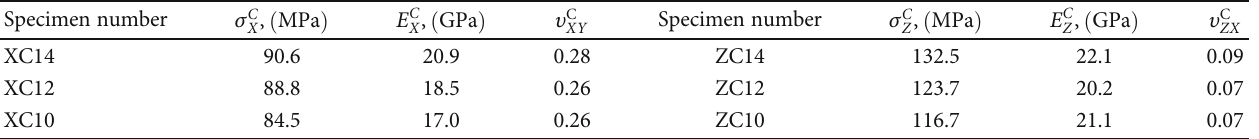
Table 5: Compression mechanical properties of axial braided C/C